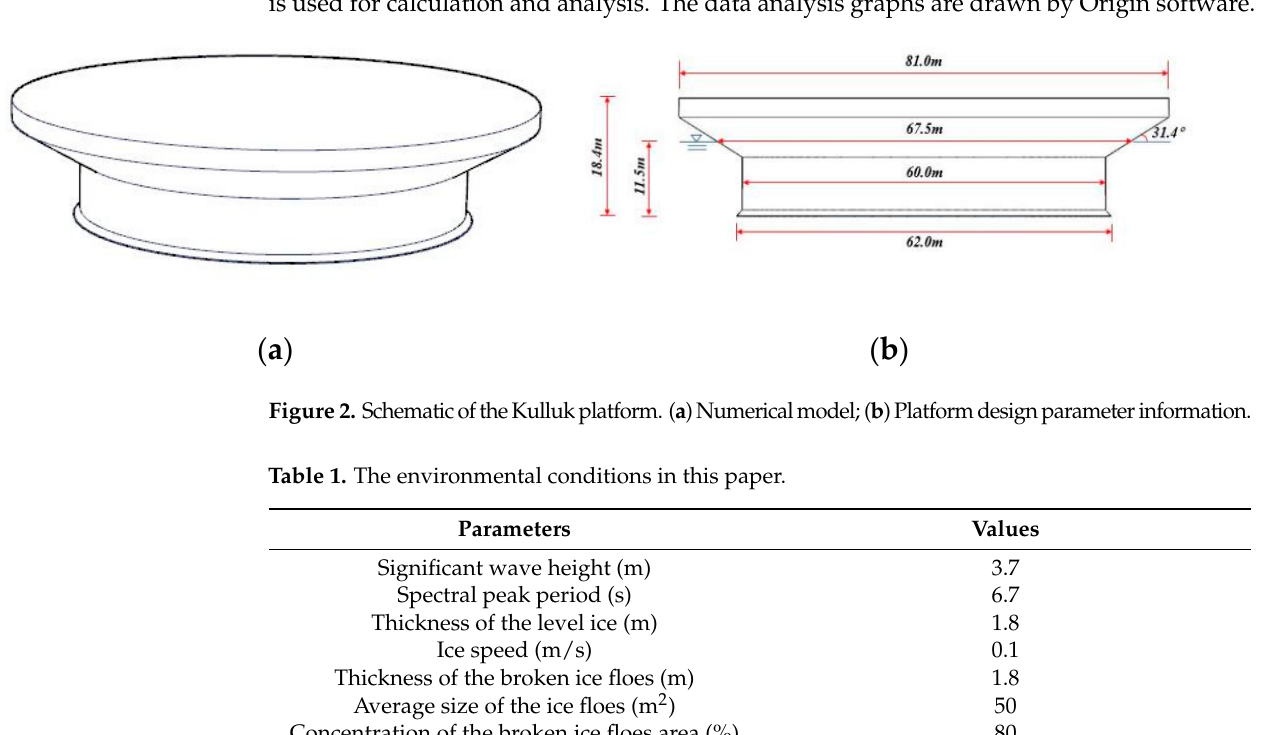
Table 1. The environmental conditions in this paper.